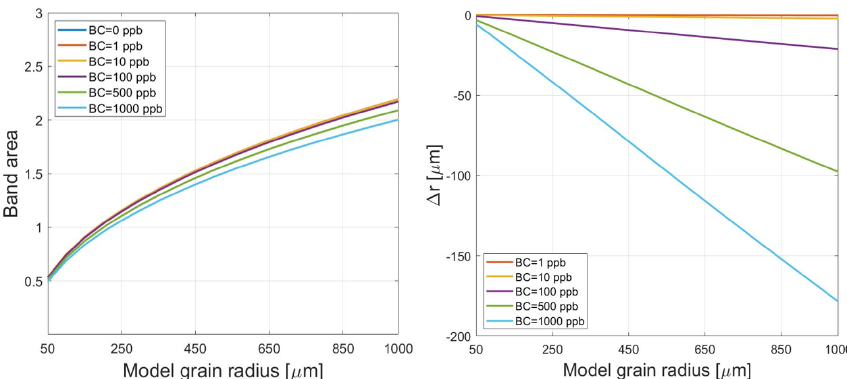
Figure 6. Same as Figs. 4 and 5 but for changes in black carbon content. Grain size errors are calculated from calibration curves assuming no impurity content.